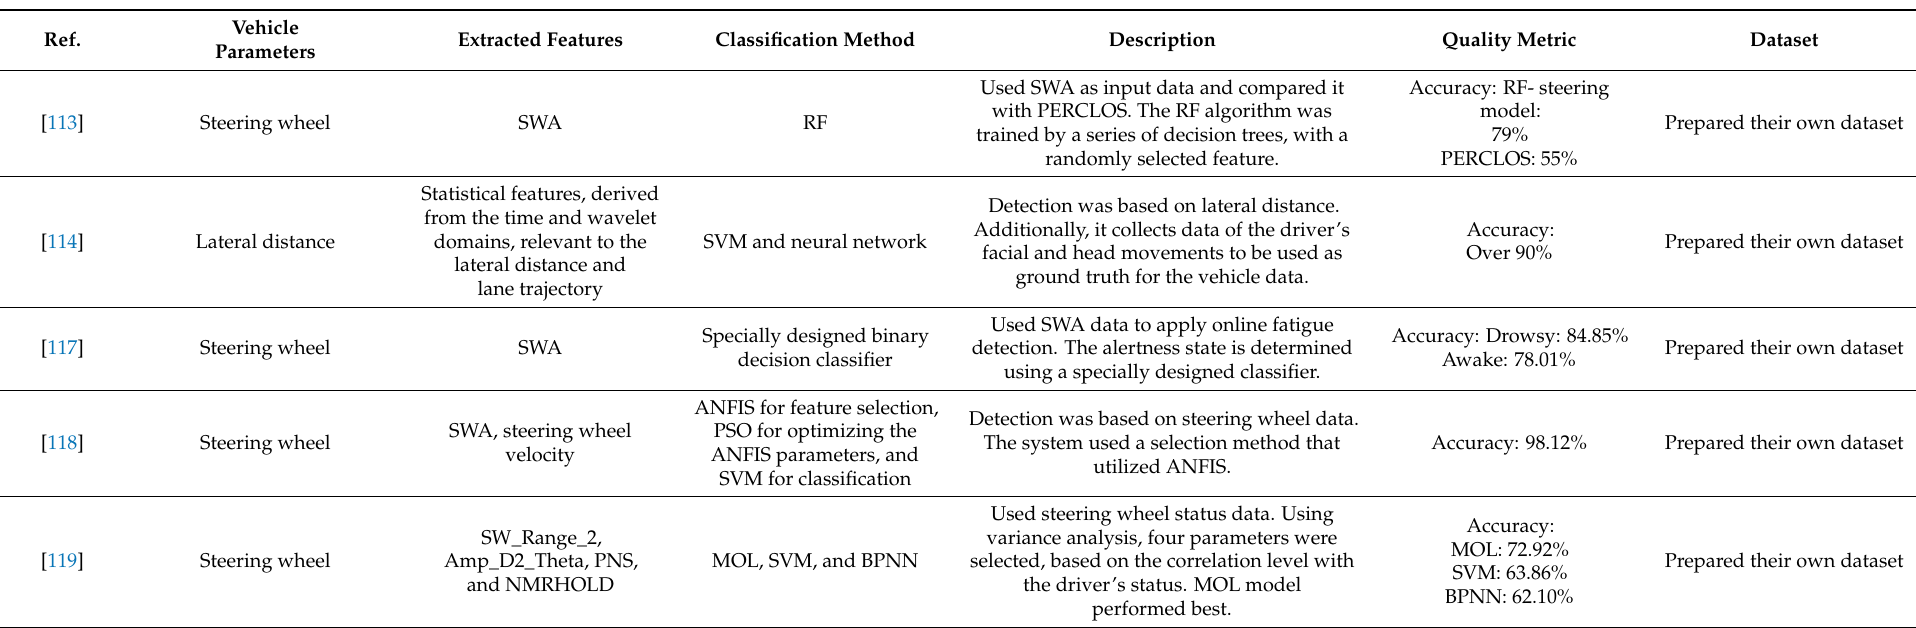
Table 7. Vehicle-based drowsiness detection